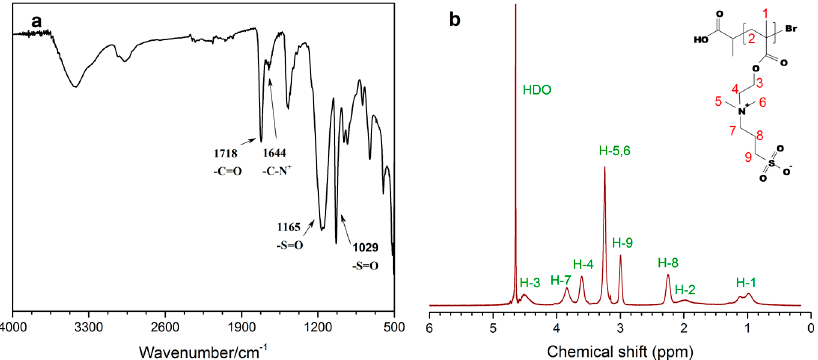
Figure 2 . FT-IR ( a ) and 1 H-NMR spectra ( b , in D 2 O) of PSBMA.